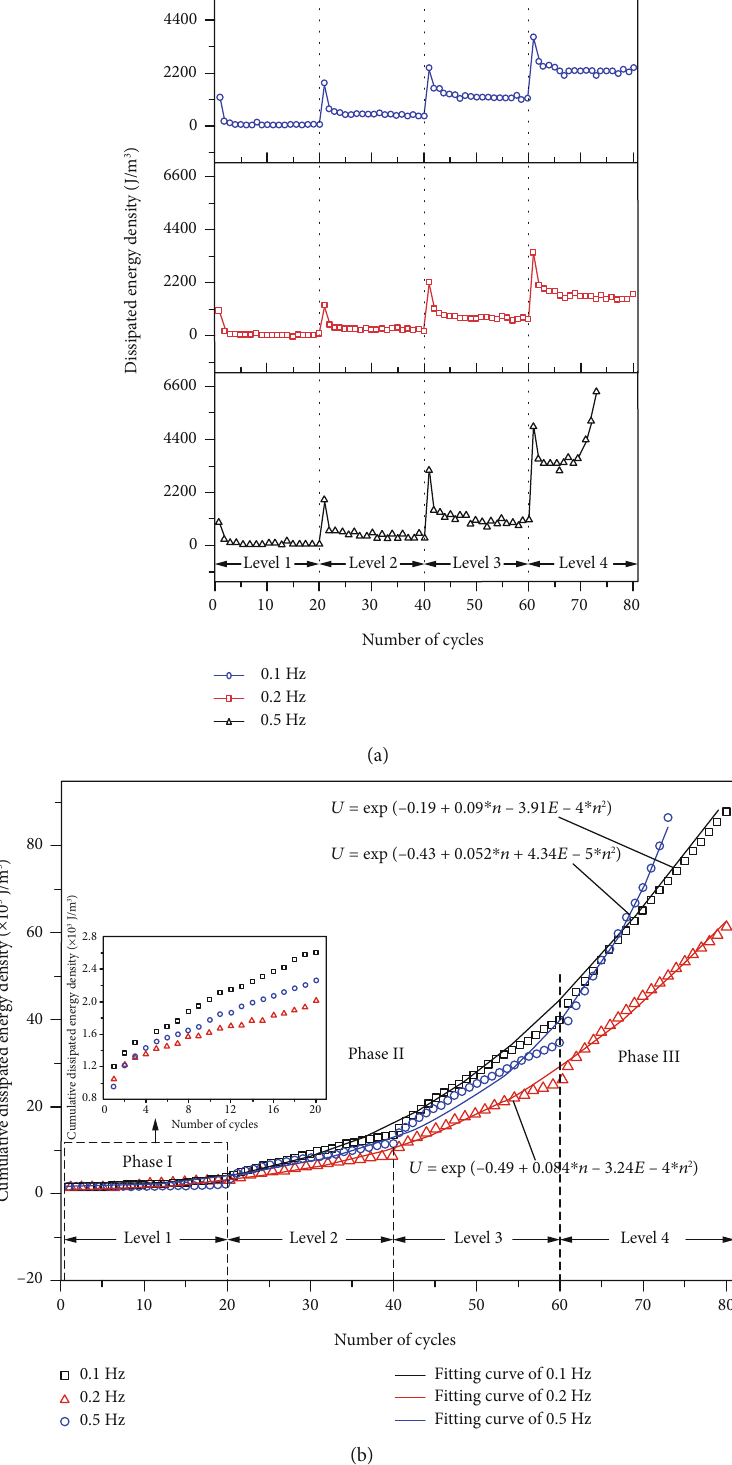
Figure 9: Evolution of dissipated energy of coal versus cycles at di ff erent loading frequencies: a dissipated energy; b cumulative dissipated energy